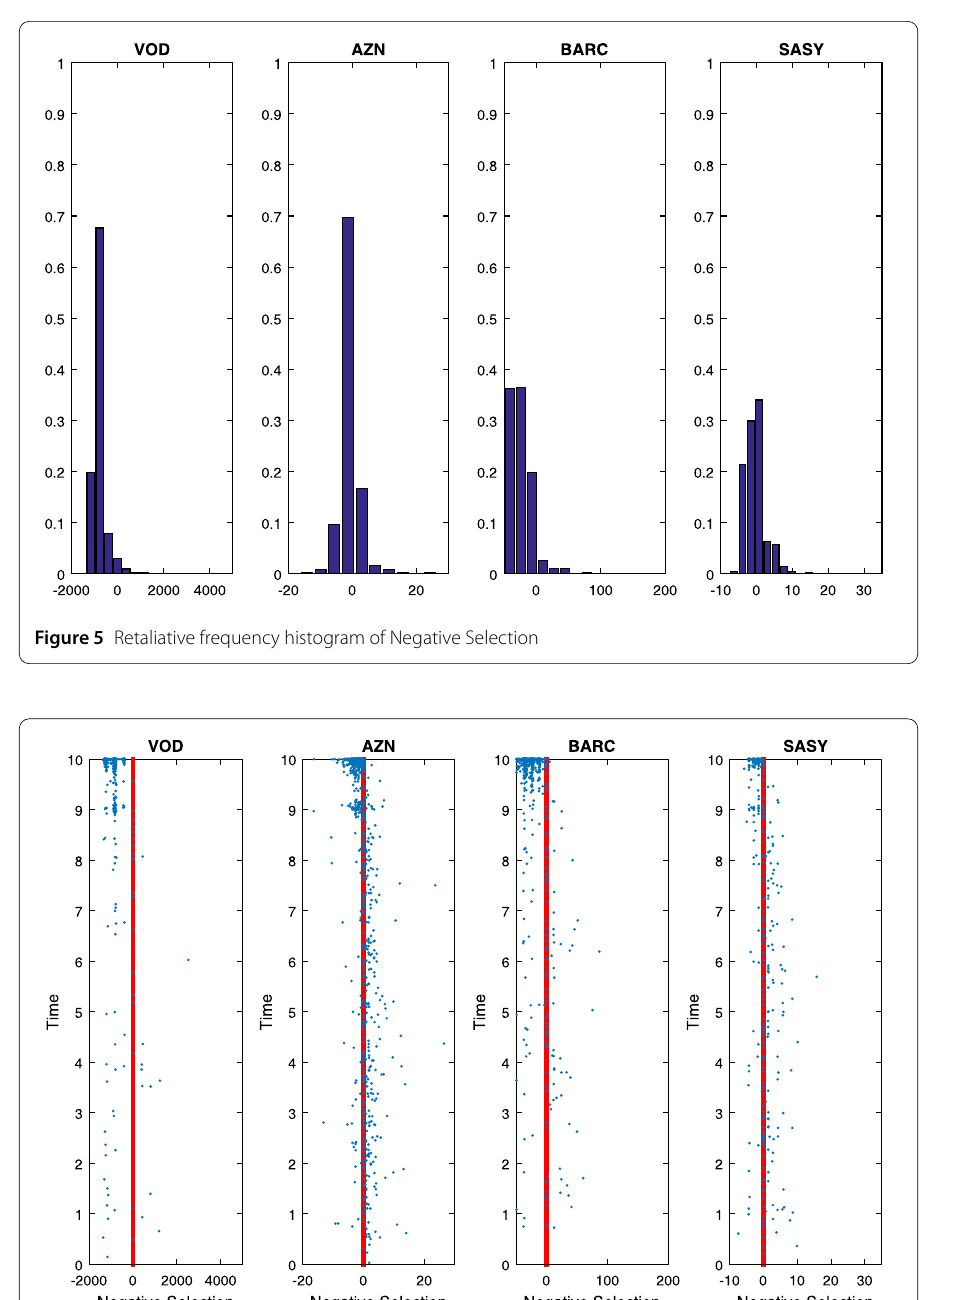
Properties of Negative Selection are tested using a simulator built in Matlab and MySQL, on real trade data for three liquid stocks from London Stock Exchange and one stock from Euronext. The obtained empirical results are aligned with the theoretical expectations and demonstrate the ability of Negative Selection to capture all important properties of a trading strategy. The comparison between NS and two main benchmarks, VWAP and IS are also